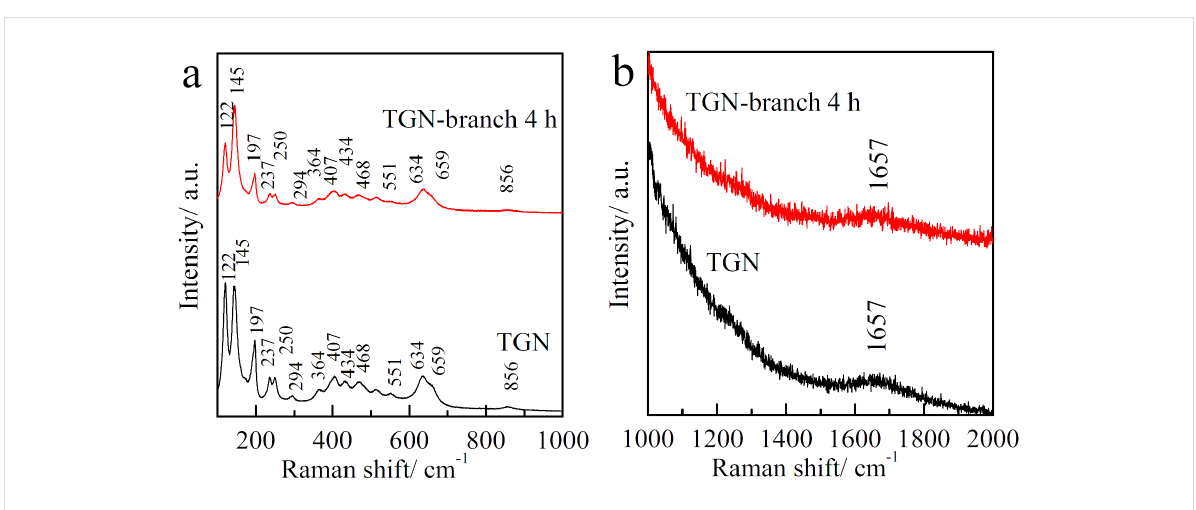
Figure 4: Raman spectra of samples TGN and TGN-branch 4 h recorded over the range of (a) 100–1000 cm − 1 and (b) 1000–2000 cm − 1 .